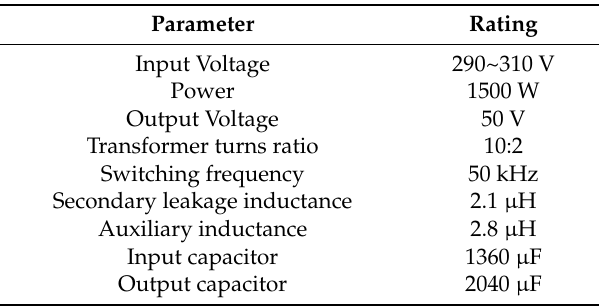
Table 3. DAB-IBDC converter design specifications 2.5